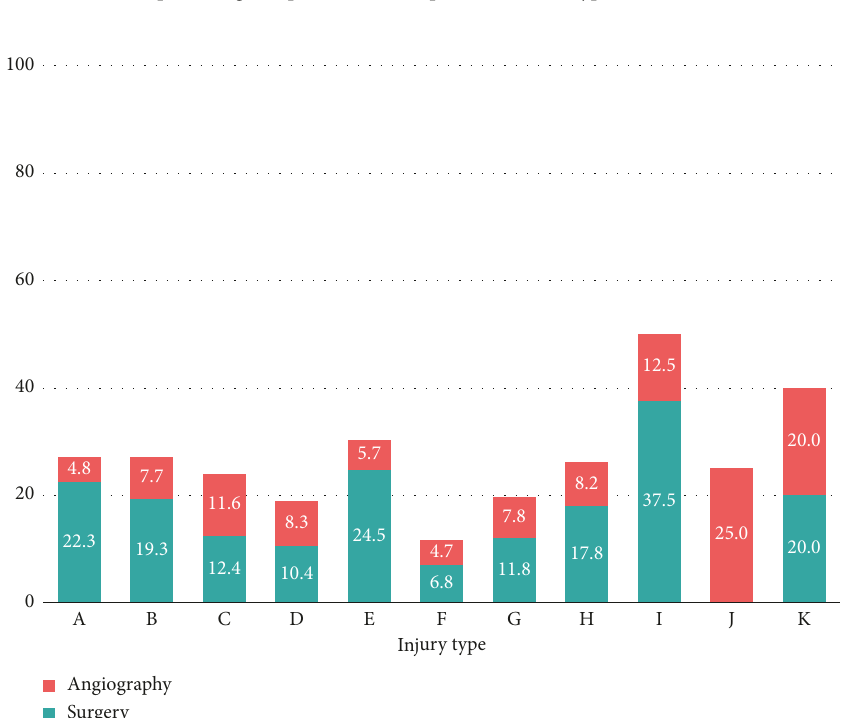
Figure 1: The percentage of patients that experienced each type of trauma mechanism.